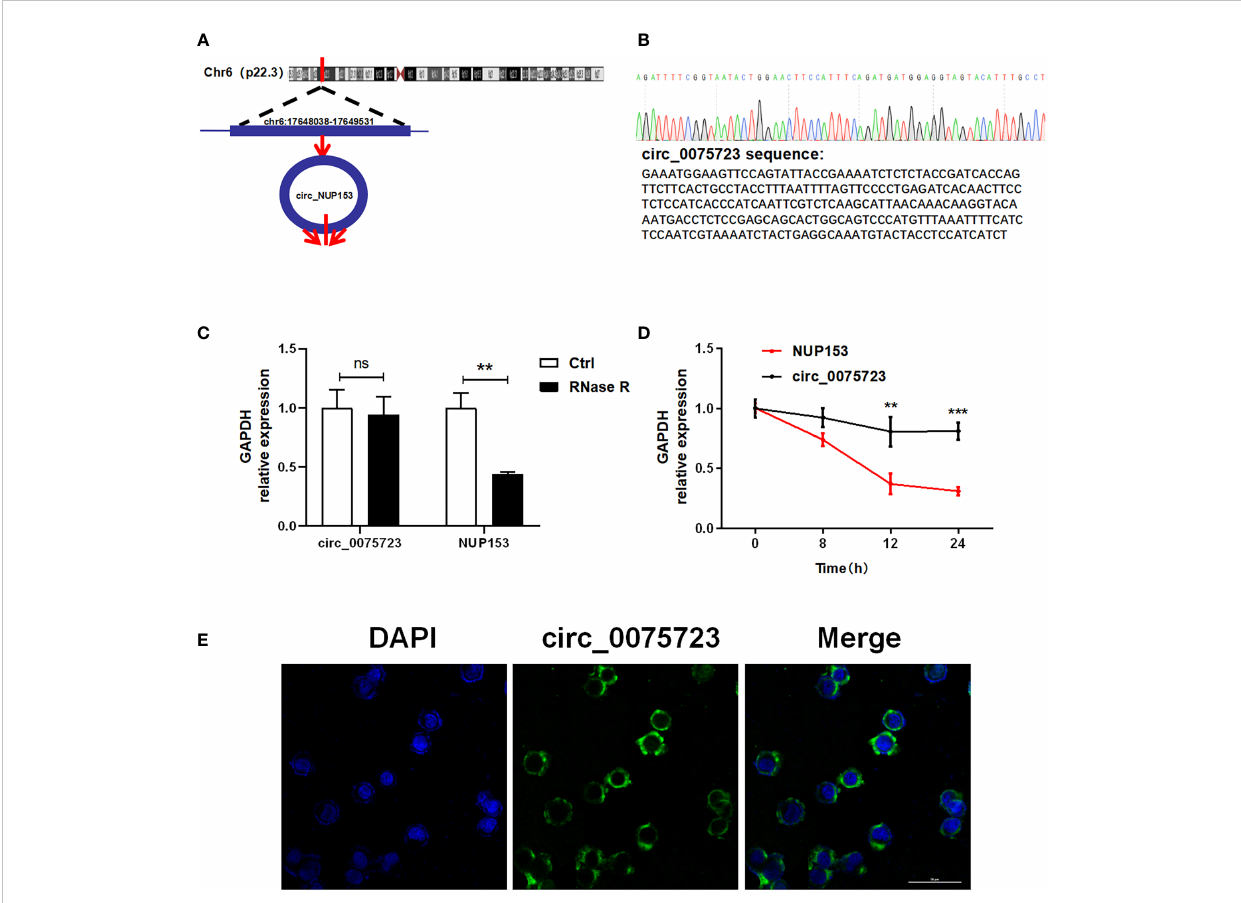
FIGURE 2 The characterization of the circ_0075723. (A) The location of circ_0075723 in genome. (B) Sanger sequencing showing the “ head-to-tail ” splicing of circ_0075723 in THP-1 cell. (C) qRT-PCR analysis of the expression of circ_0075723 and NUP153 in THP-1 cells after treatment with RNase R. Data are presented as means ± SD; signi fi cant difference was identi fi ed with two-way ANOVA. **p < 0.01; ns: no signi fi cant. (D) qRT-PCR analysis of the expression of circ_0075723 and NUP153 in THP-1 cells after treatment with actinomycin (D) Data are presented as means ± SD; signi fi cant difference was identi fi ed with Student t -tests. **p < 0.01, ***p < 0.001 (E) RNA FISH for circ_0075723. Nuclei were stained with